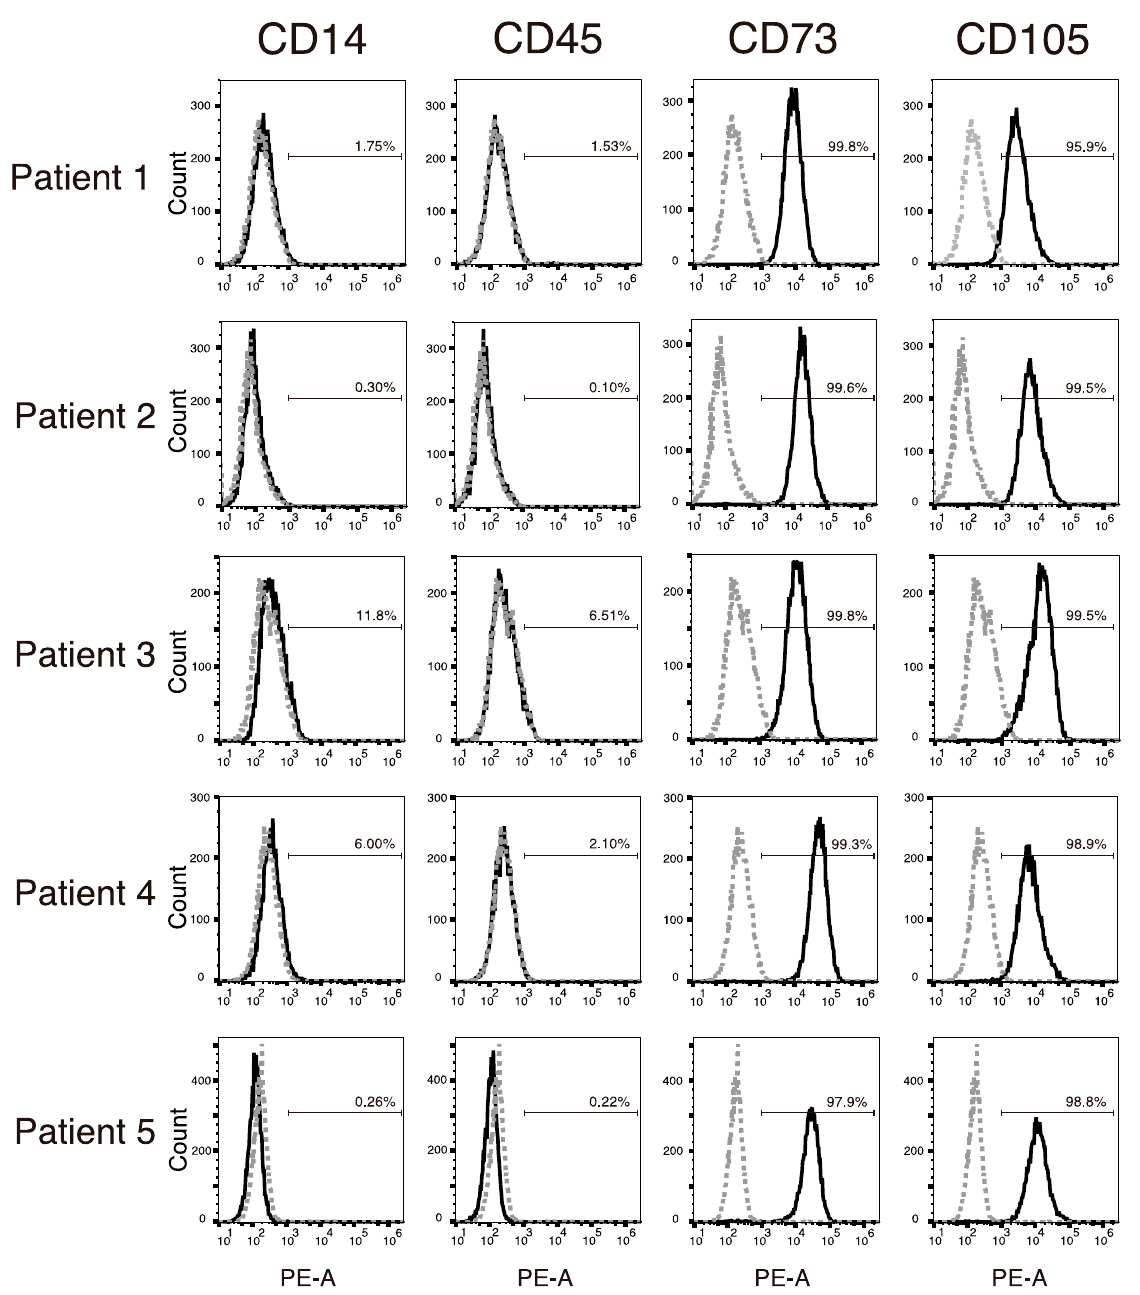
Figure 2. Flow cytometric analysis of the expression of cell surface markers of non-hypertrophic nonunion cells (NHNCs). Gray dotted lines are isotype control. Positive percentage of the cell surface is shown in each histogram.